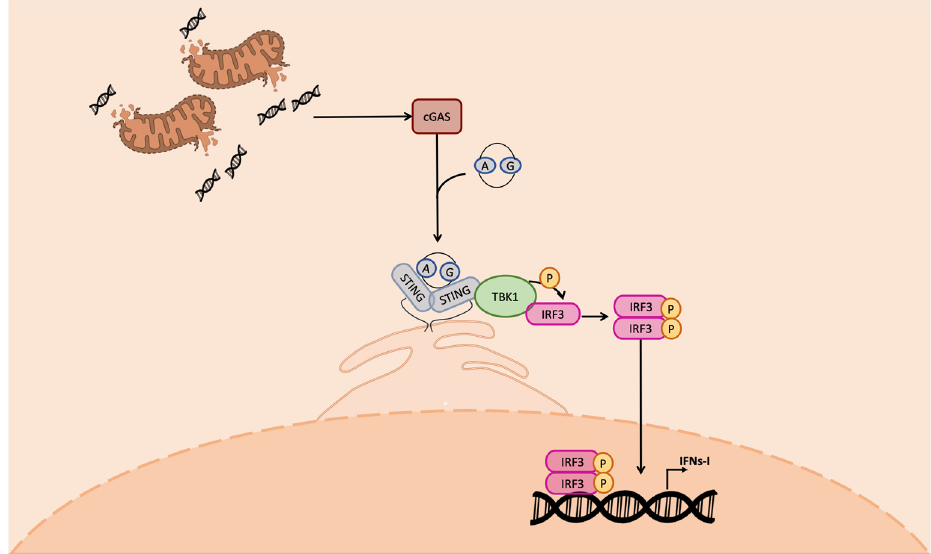
Figure 5. mtDNA stress activates the cGAS-STING pathway. During viral infection, mitochondria undergo the induction of a stressed state, during which the mtDNA nucleoids lose their compacted state and are released into the cytoplasm, where mtDNA is detected by cGAS, activating the cGAS- STING pathway.